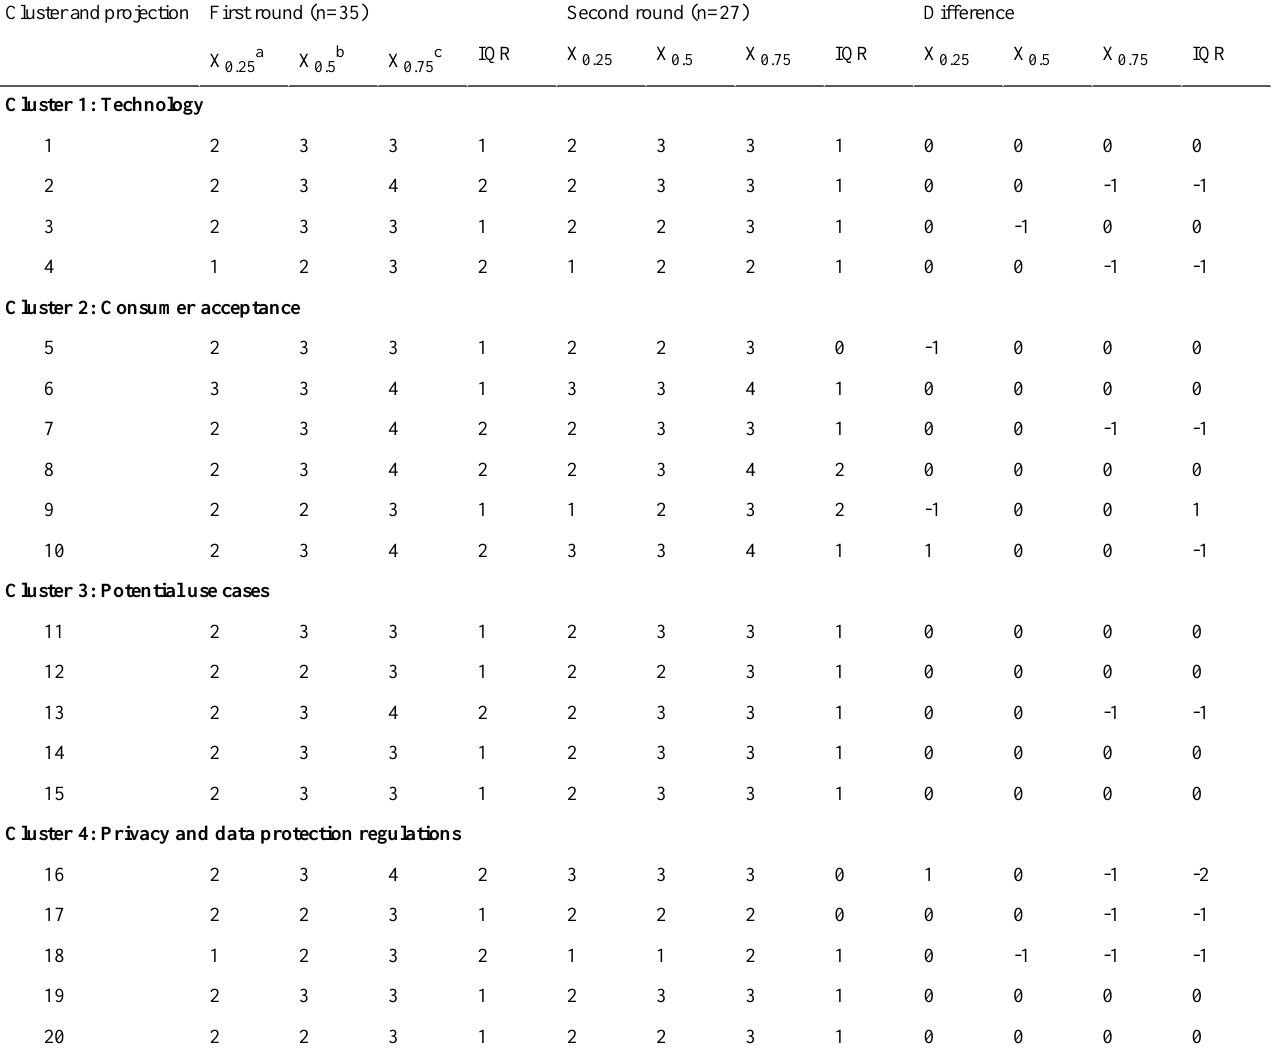
DifferenceSecond round (n=27)First round (n=35)Cluster and